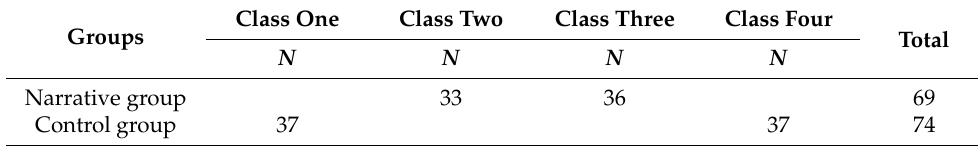
Table 1. Composition of participants ( N = 143). Class Groups